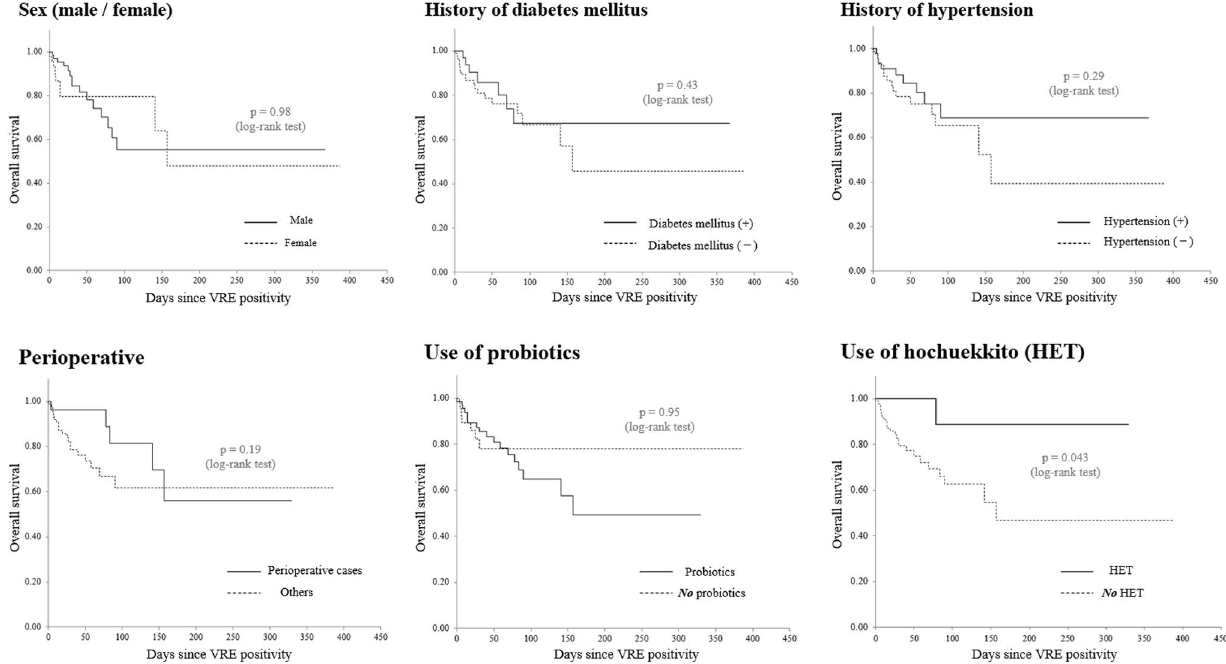
Figure 1. Overall survival analysis with each clinical and therapeutic variable. p -values were obtained by log-rank tests. The use of hochuekkito for the treatment of vancomycin-resistant enterococcus significantly contributed to a better overall survival. Meanwhile, the presence of diabetes mellitus or hypertension, perioperative status, probiotics, and sex did not significantly affect overall survival in this